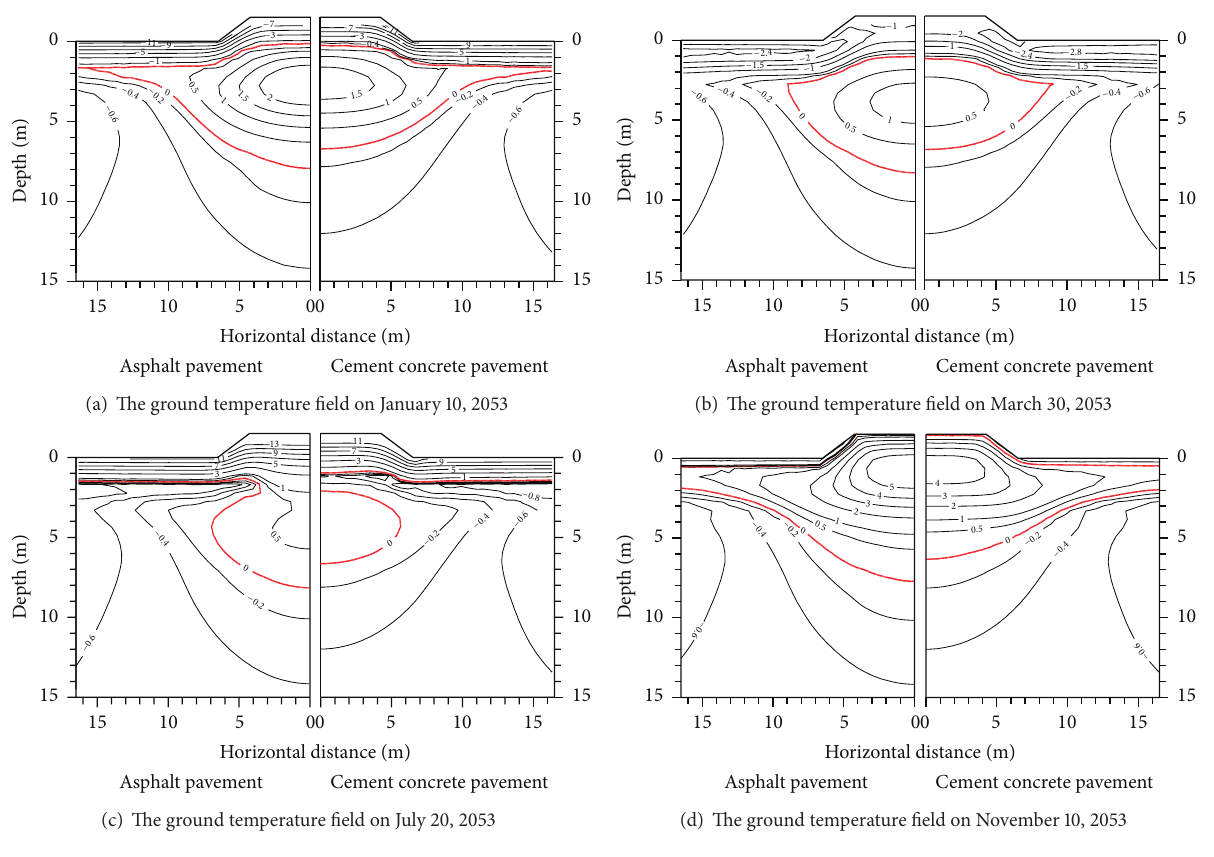
Figure 8: Temperature values of the 50th year under concrete pavement and asphalt pavement (width of 8.5m).